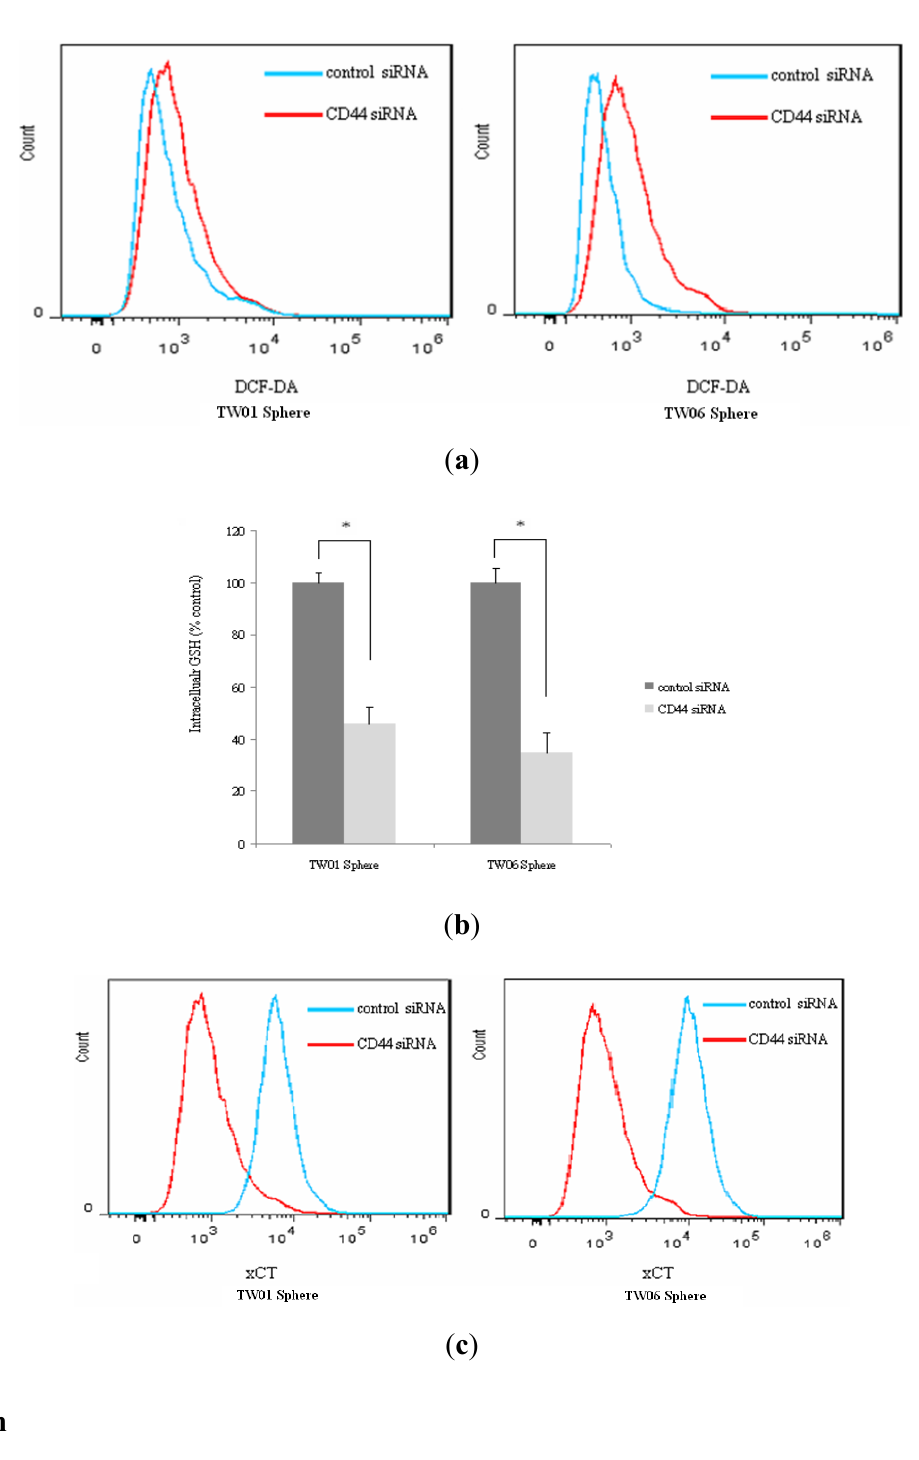
Figure 5. CD44 correlates with ROS defense, intracellular GSH level and cell surface xCT expression in NPC sphere cells. ( a ) Flow cytometric analysis of ROS level after CD44 knockdown by control and CD44 siRNA; ( b ) Intracellular GSH level of sphere cells was reduced after transfected with CD44siRNA. * p < 0.05; ( c ) Expression of cell surface xCT was analyzed after CD44 knockdown by control and CD44